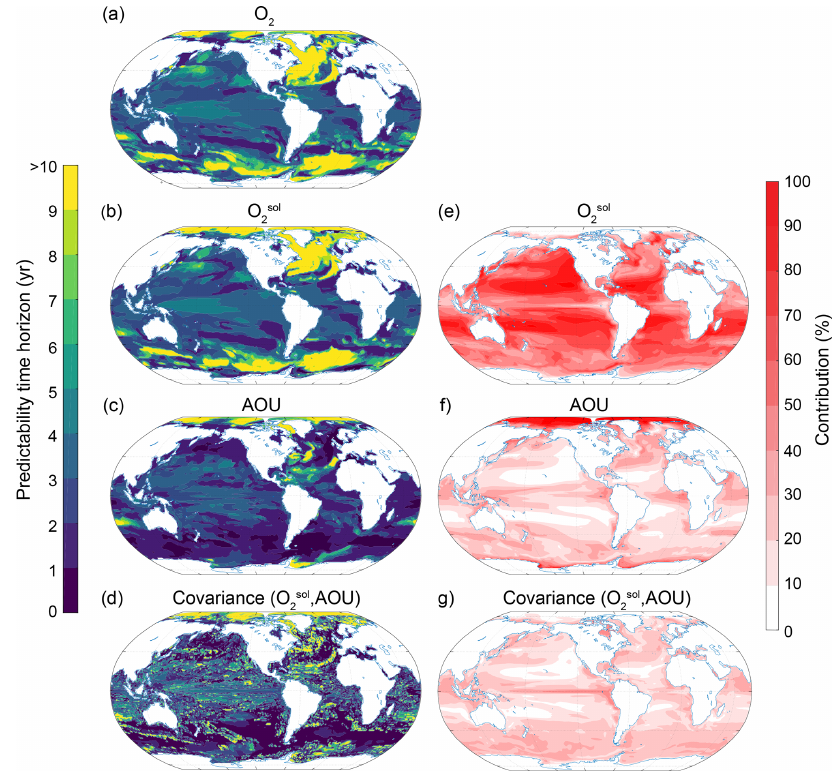
Figure 7. Spatial pattern of the (a–d) predictability time horizons and (e–g) contribution of different terms to the predictability of oxygen at the surface. (a–d) Predictability time horizon for (a) O 2 , (b) O sol , (c) AOU and (d) covariance between O sol and AOU. (e–g) Percentage 2 2 contributions of (e) O sol , (f) AOU and (g) covariance between O sol and AOU relative to the sum of all terms. Red shading in panels (e) – (g) 2 2 represents positive absolute values of the variance and covariance terms. The percentage contributions are shown as averages over the entire 10 years of the simulations. The percentage contributions do not change substantially over the 10 years (always within ± 5% of the 10-year